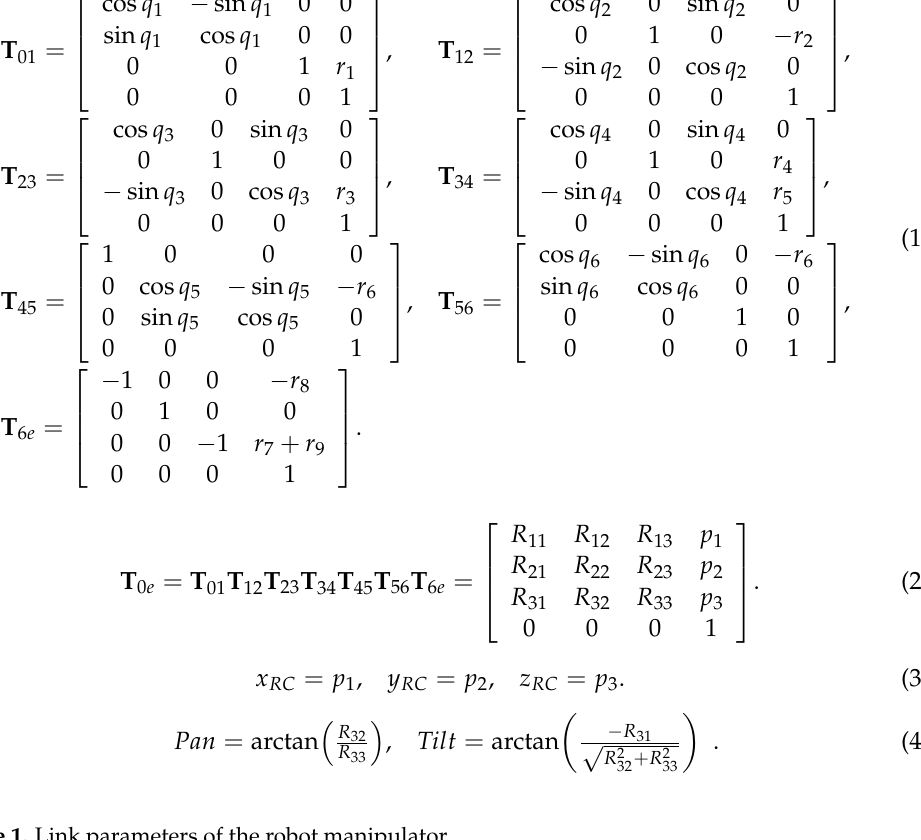
Table 1. Link parameters of the robot